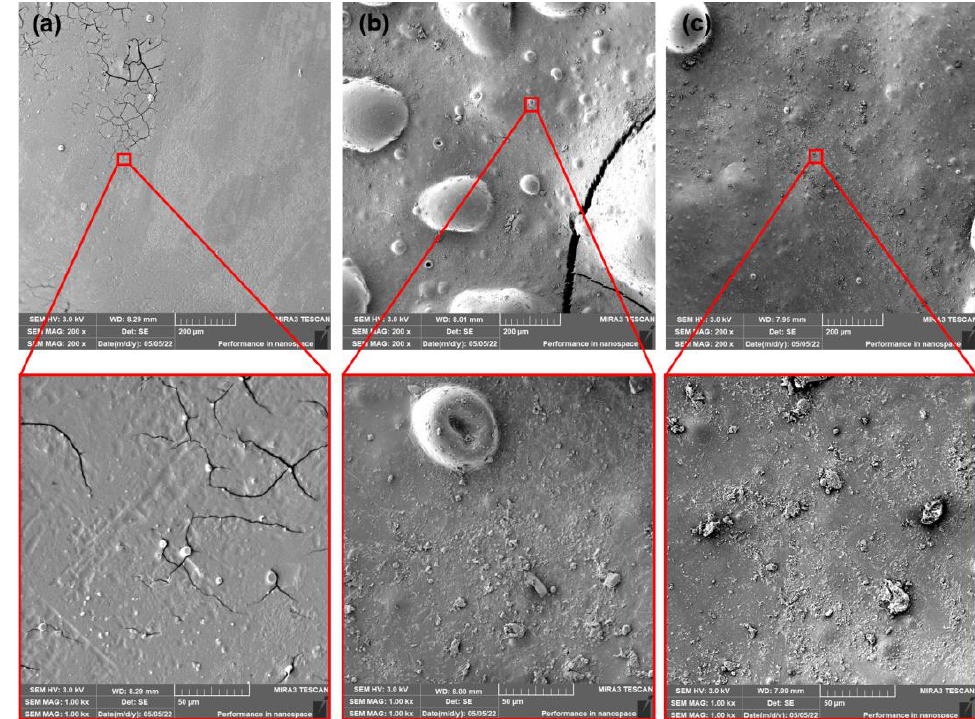
Figure 11. SEM images of aged PLA/PEG films ( a ) at initial state and after ( b ) 14 days of thermophilic composting, and ( c ) 28 days of thermophilic composting.